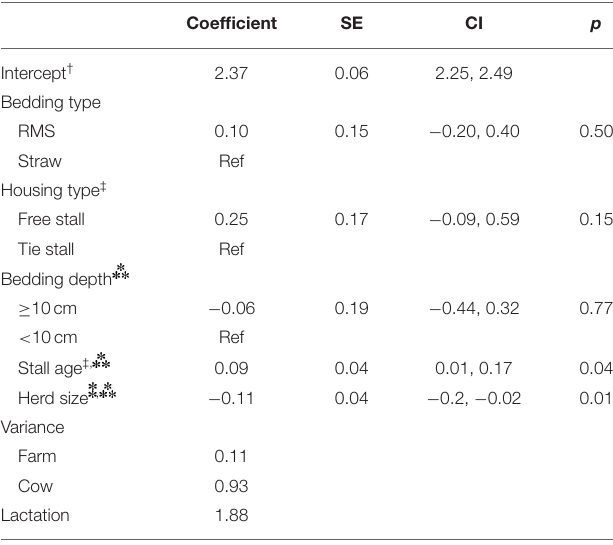
TABLE 2 | Impact of bedding on the cow’s mean lactation linear score estimated using a generalized linear mixed model using the data from 15,161 lactations